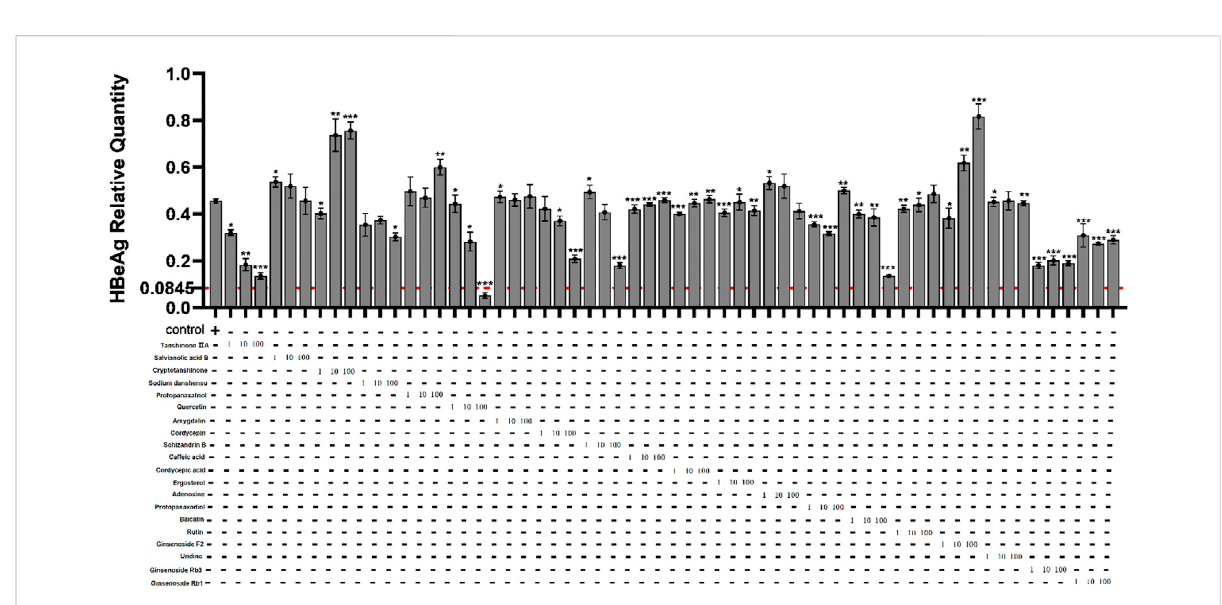
FIGURE 8 Effectsof20mainactivecompoundsofFZHYontheHBeAgproductioninHepG2.2.15cells.Eachgroupvs.controlgroup,* p < 0.05,** p < 0.01, *** p <